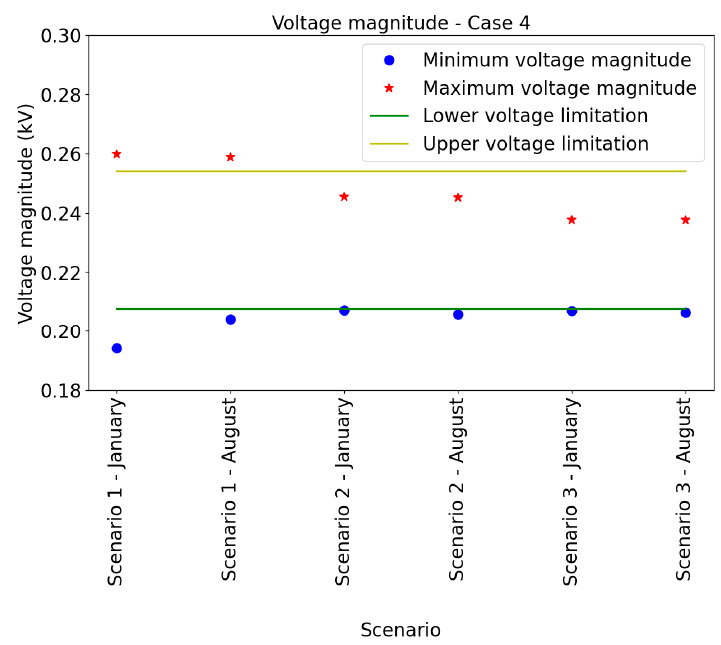
Figure 10. Minimum and maximum voltage magnitude—Case 4.